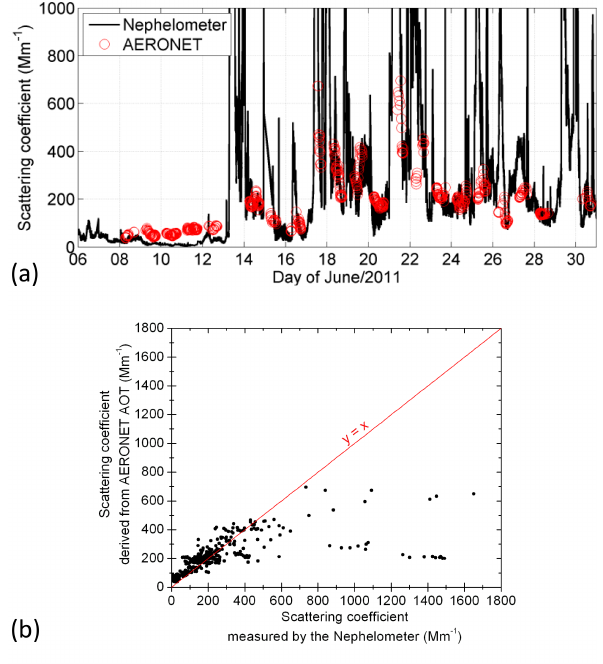
Figure 13. Intercomparison of AERONET total column measure- ments with ground-based measurement at SS1 in Algeria. (a) Scat- tering coefficient measured by the nephelometer at the Fennec tower compared to AERONET AOT normalized by a factor of 5km. (b) Scatterplot of the scattering coefficient obtained by normalizing AERONET AOT by a factor of 5km and measured by the neph-